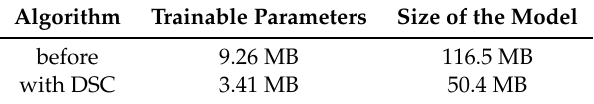
Table 6. Size of the model before and after applying the DSC on FC-DenseNet103 network.